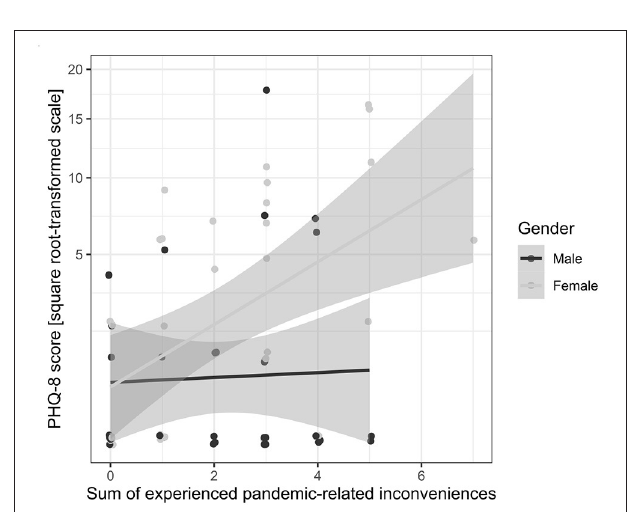
FIGURE 3 | The raw total scores in PHQ-8 plotted against the sum of the pandemic-related inconveniencies experienced by anyone in the household of the respondent, with regression lines fitted separately for females and males. Gray bands show 95% confidence intervals for regression